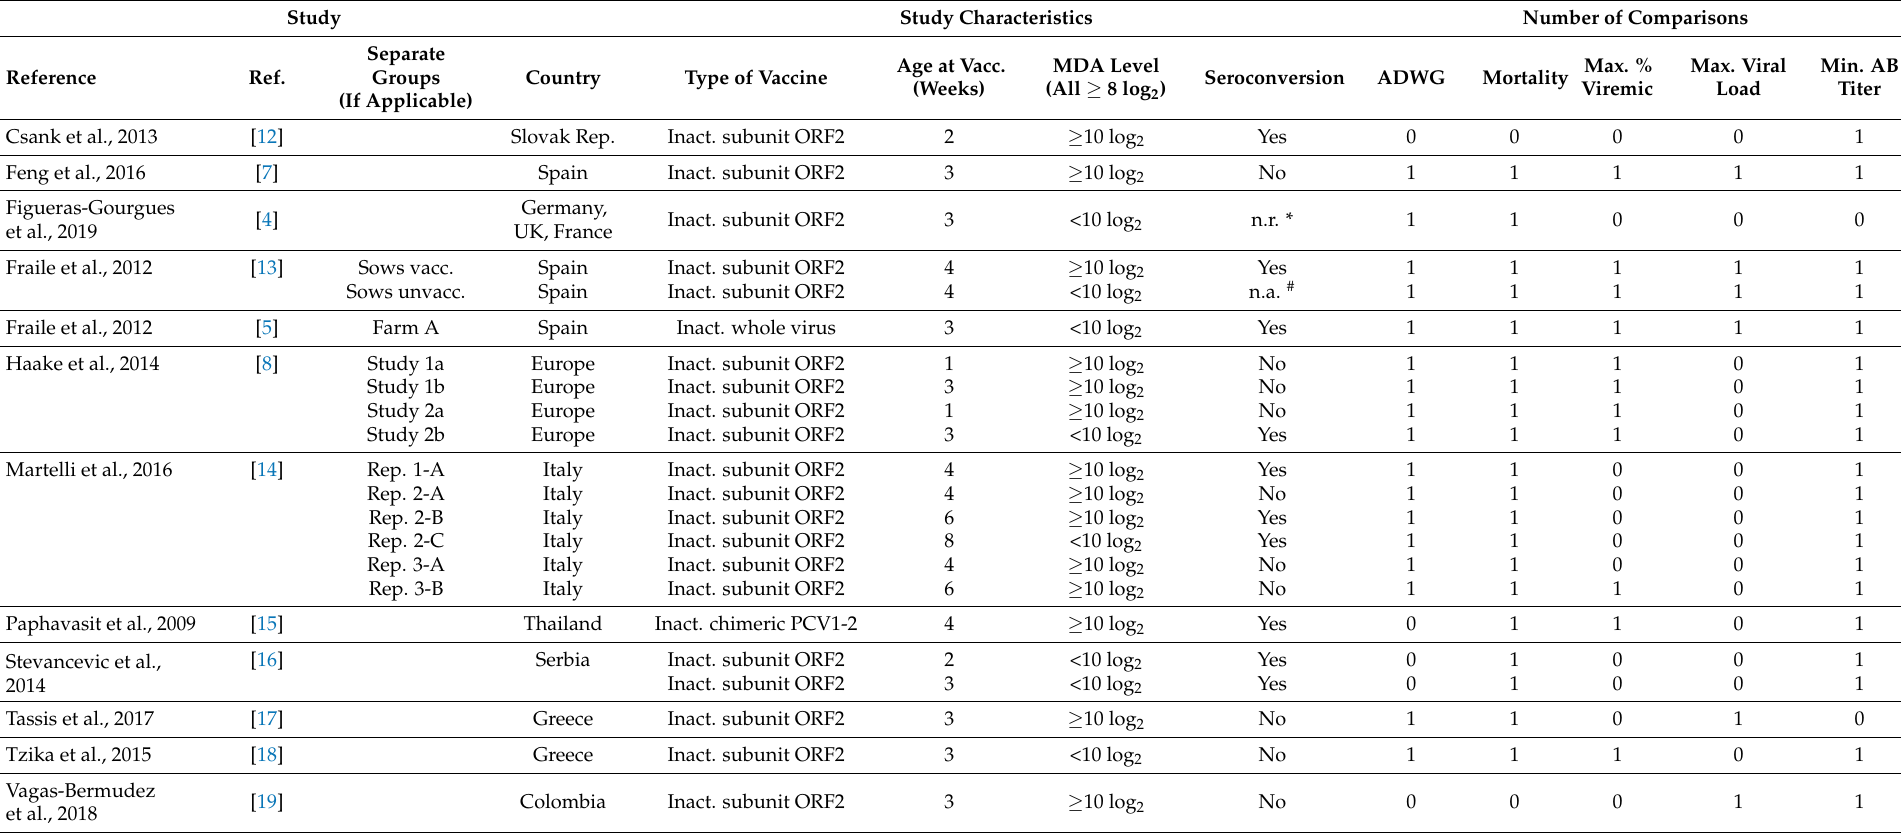
Table 1. Characteristics of studies identified through semi-systematic literature search and included for the evaluation of interference of MDA with the effectiveness of vaccination against